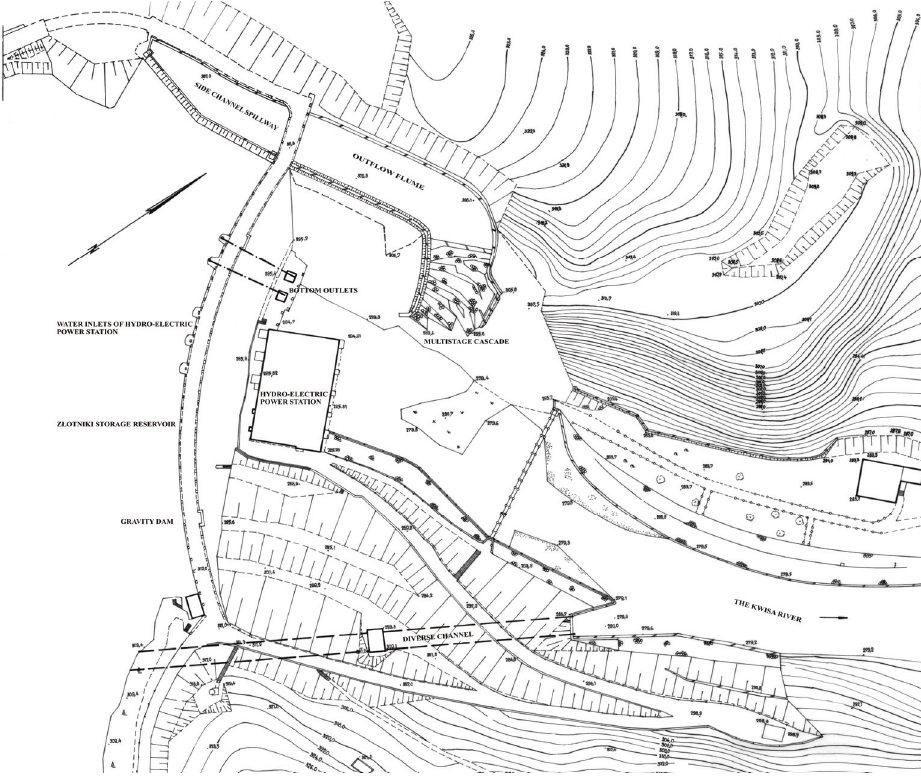
Fig. 1. Functional plan of the Złotniki